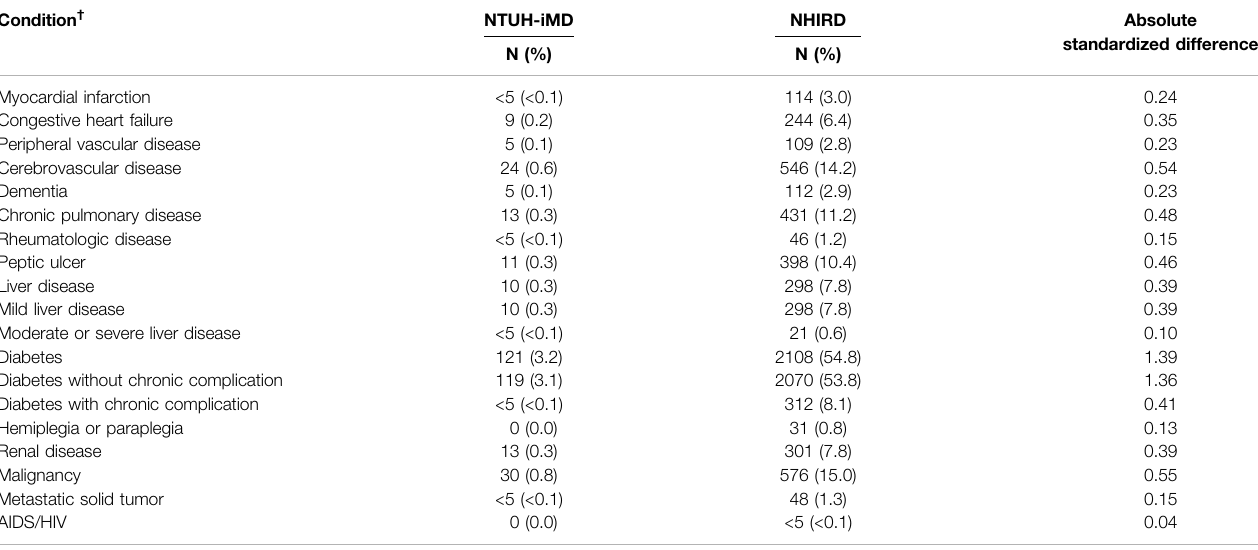
TABLE 3| Comorbidities captured during the6-monthbaselineperiod intheIntegrated Medical Database ofNationalTaiwan UniversityHospital (NTUH-iMD) andthelinked National Health Insurance Research Database (NHIRD) among oral hypoglycemic agent users with continuous 6-month baseline and 24-month follow-up data ( n = 3,845).